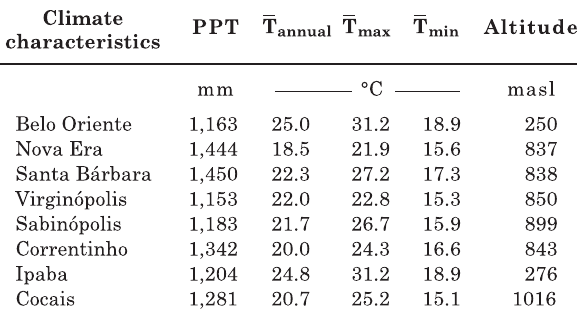
Table 2. Climate characteristics and elevation of the studied areas (sites)